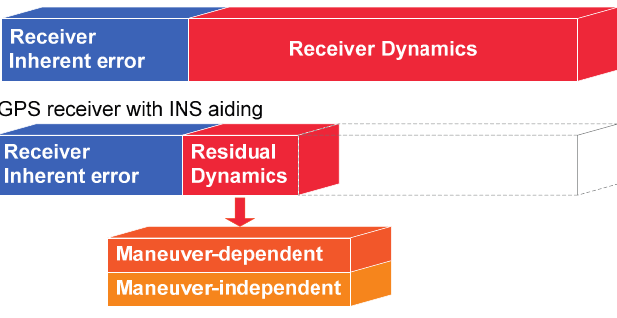
Figure 2. The residual dynamics of the tracking loop with INS